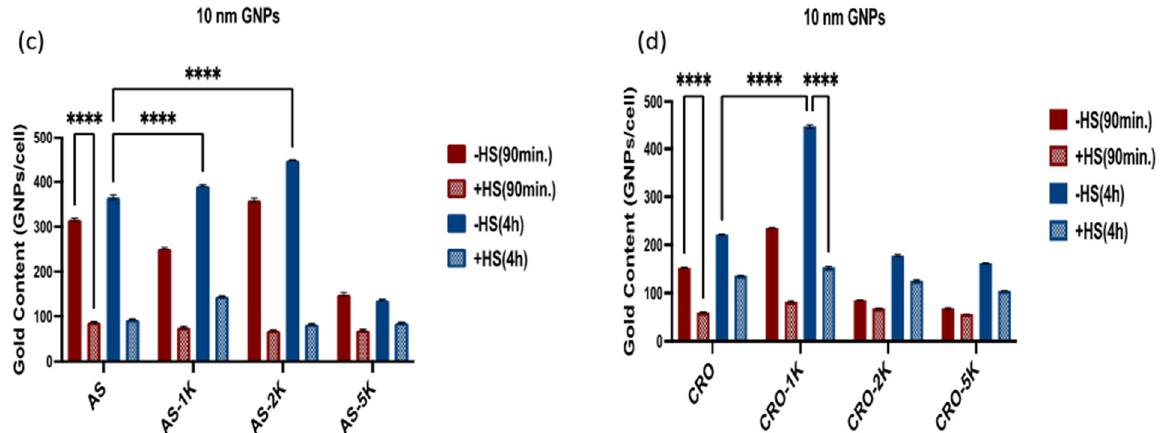
Figure 6. Cellular uptake of the GNP contrast agent by MDA-MB-231 cells with and without human serum after 90 min and 4 h. ( a ) The 4 nm group of GNPs conjugated with AS1411. ( b ) The 4 nm group of GNPs conjugated with CRO. ( c ) The 10 nm group of GNPs conjugated with AS1411. ( d ) The 10 nm group of GNPs conjugated with CRO. Each data point represents the mean ± standard deviation (SD) of triplicate experiments. **** denotes p < 0.0001.